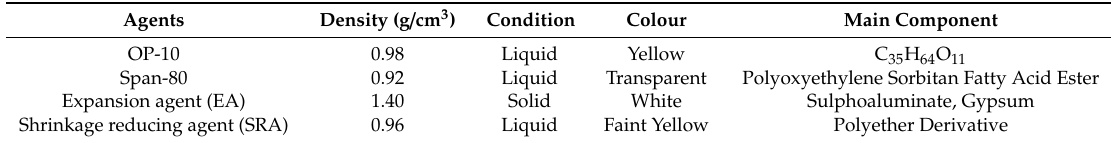
Table 3. Properties of agents.